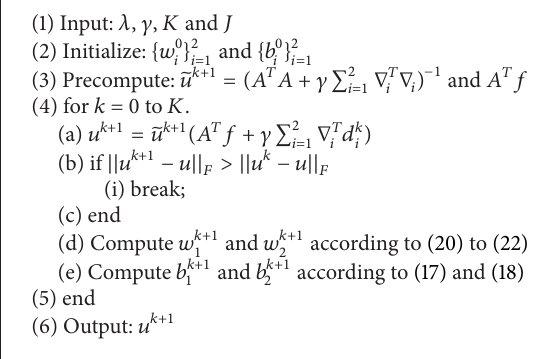
Algorithm 1: Proposed algorithm: SBMTV 𝑝